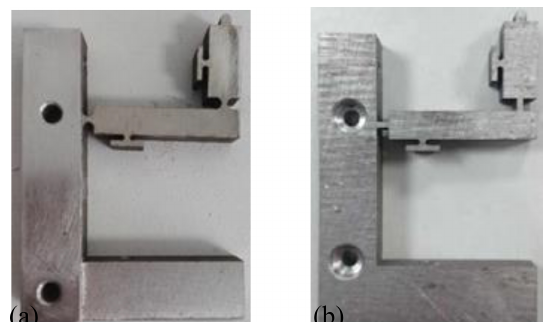
Figure 14. Specimen of the compliant lever mechanism based on the RCF and the CRF. (a) Specimen based on the RCF. (b) Speci- men based on the